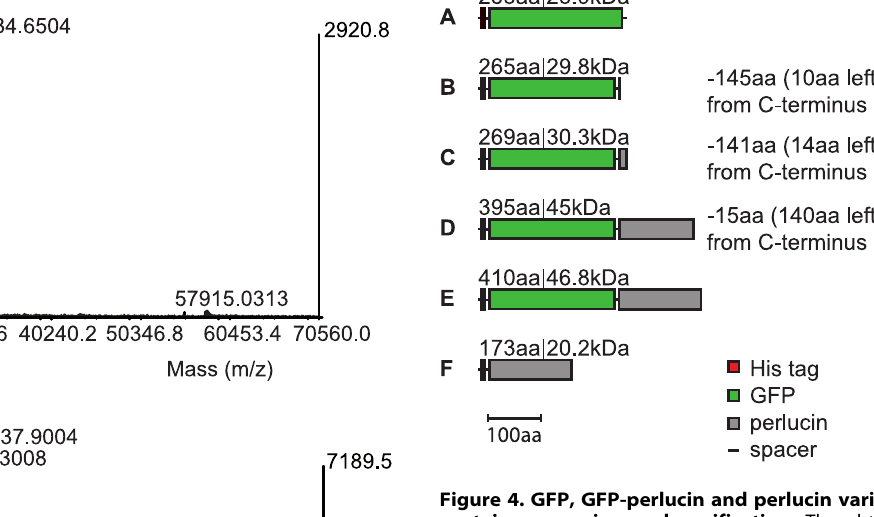
Figure 4. GFP, GFP-perlucin and perlucin variants achieved by protein expression and purification. The obtained GFP-perlucin derivatives as identified by MALDI-TOF/TOF (MS + MS/MS), either intact or after trypsin digestion, are His-tagged GFP (A), and truncated GFP- perlucins lacking 141 or 145 (B,C), or 15 C-terminal amino acids (D). Mass fragments of tryptic peptides extracted after SDS-PAGE identified the 46.8 kDa protein as the full length His-tagged GFP-perlucin including the two C-terminal repeat motifs (E). His-tagged perlucin without GFP domain (F) was not analyzed.